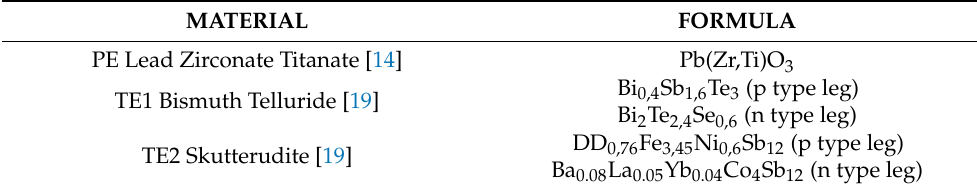
Table 2. Materials for energy